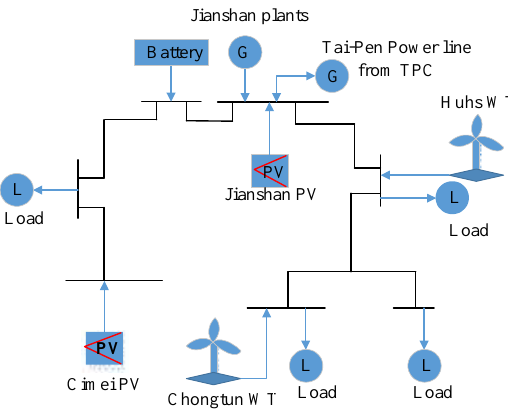
Figure 6. Construction of Penghu microgrid (MG). Energies 2018 , 11 , x FOR PEER REVIEW Table 1. Associated data of Penghu MG.